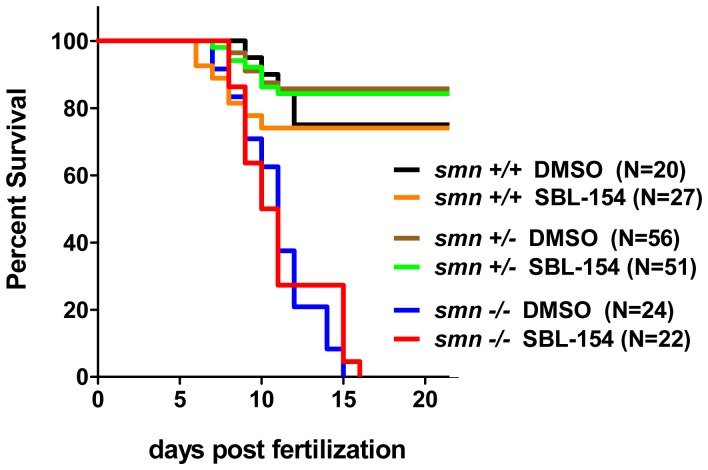
Failure of SBL-154 to extend lifespan of smn −/− zebrafish larvae.Larval progeny of smn +/− parents were treated with 2 µM SBL-154 or DMSO vehicle. Kaplan-Meier survival curves for the genotyped larvae are shown. The log-rank test for statistical significance indicates no difference between DMSO- and SBL-154-treated larvae for any of the three genotypes (p = 0.77, 0.84, and 0.52 for the wild-type, heterozygote, and mutant larvae, respectively).